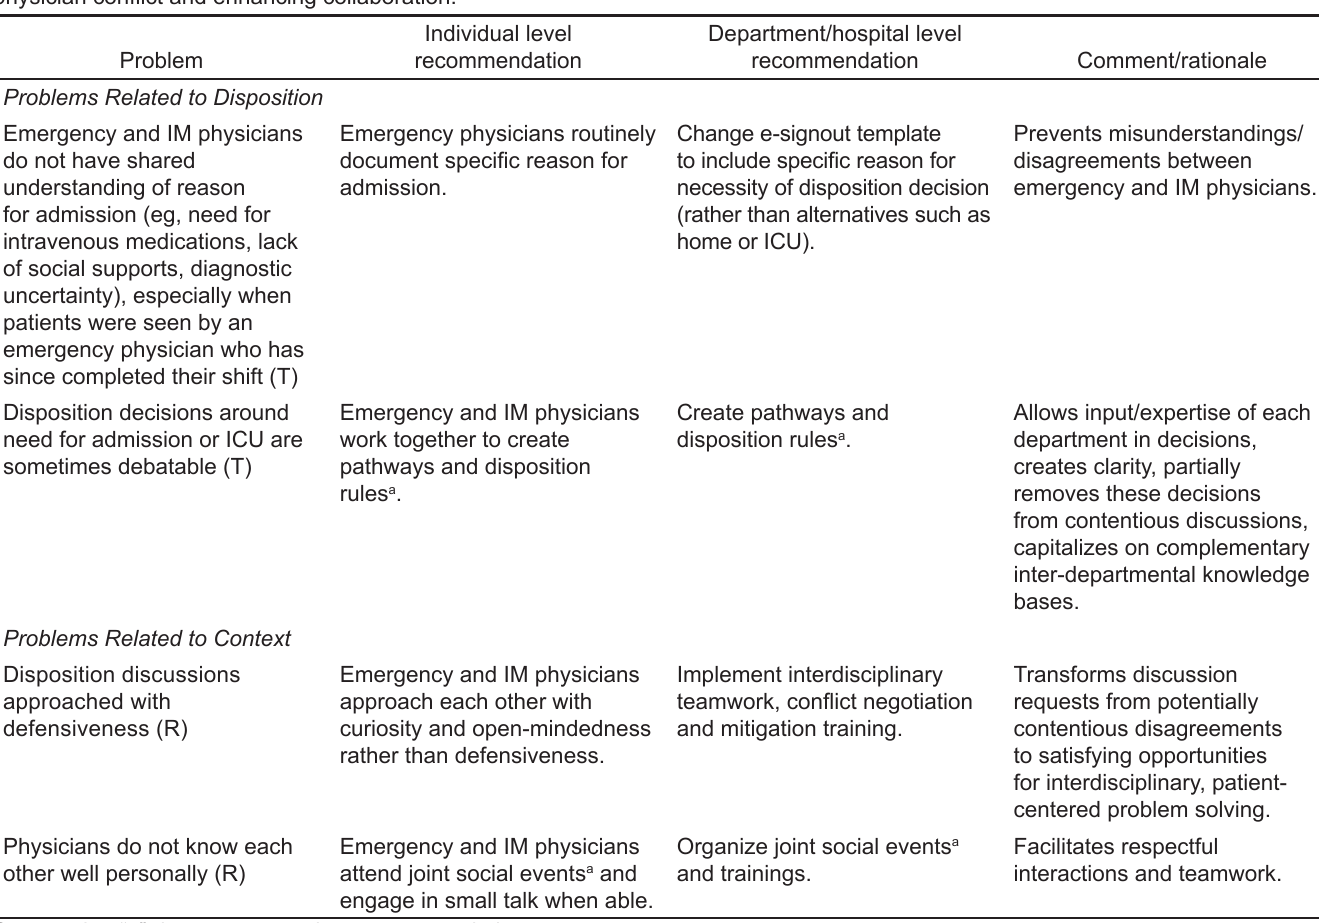
Superscript “a” denotes respondent